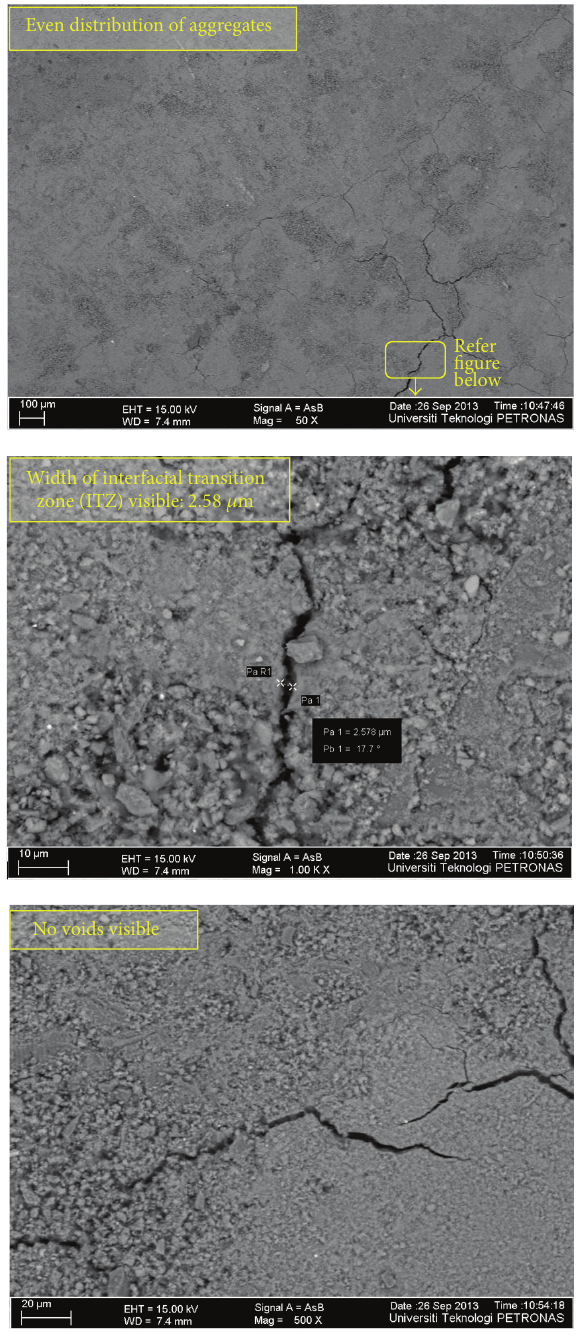
Figure 11: Microstructure of concrete mix “S-0.” Figure 12: Microstructure of concrete mix